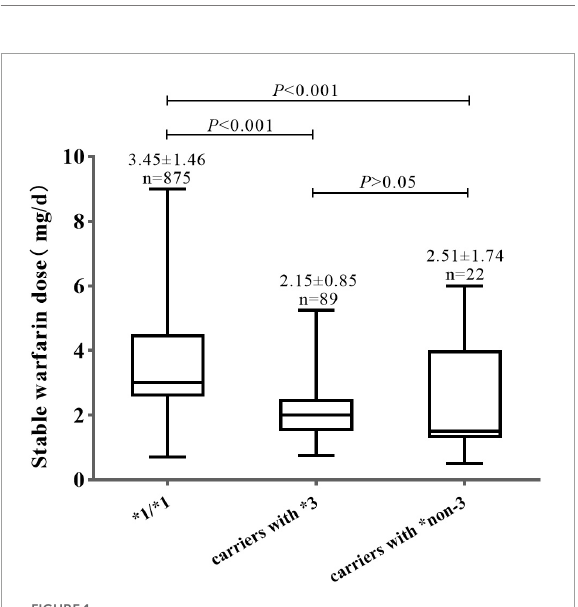
FIGURE1 Warfarin dosage distribution in different CYP2C9 genotype